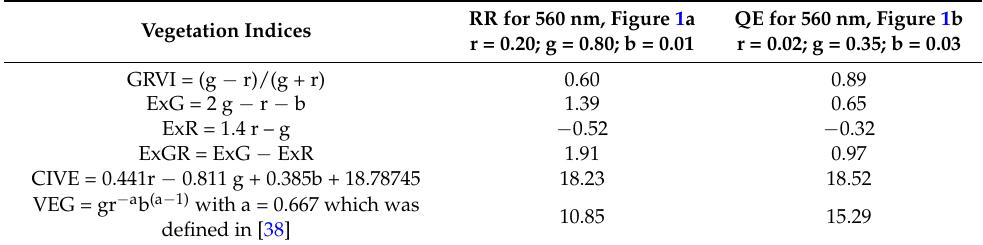
Table 2. Vegetation indices values for RR and QE for a wavelength of 560 nm. Vegetation